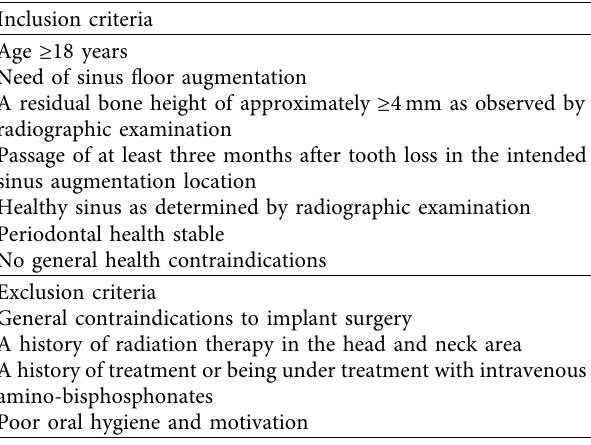
Table 1: Inclusion and exclusion